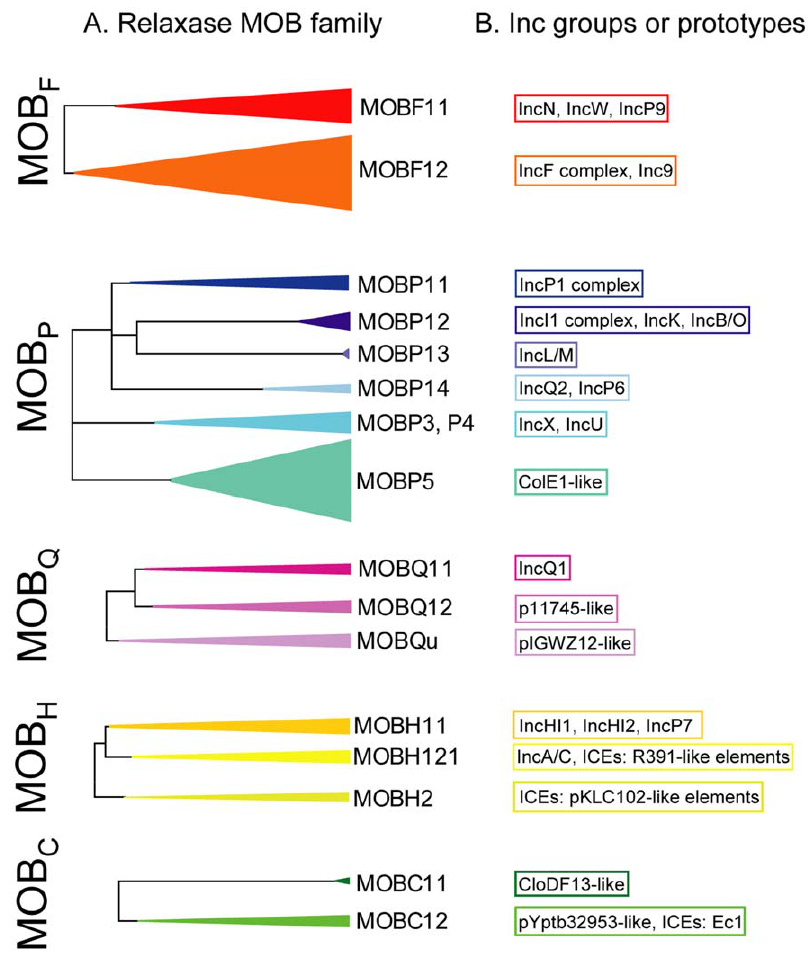
Validation and Methodologies Comparison